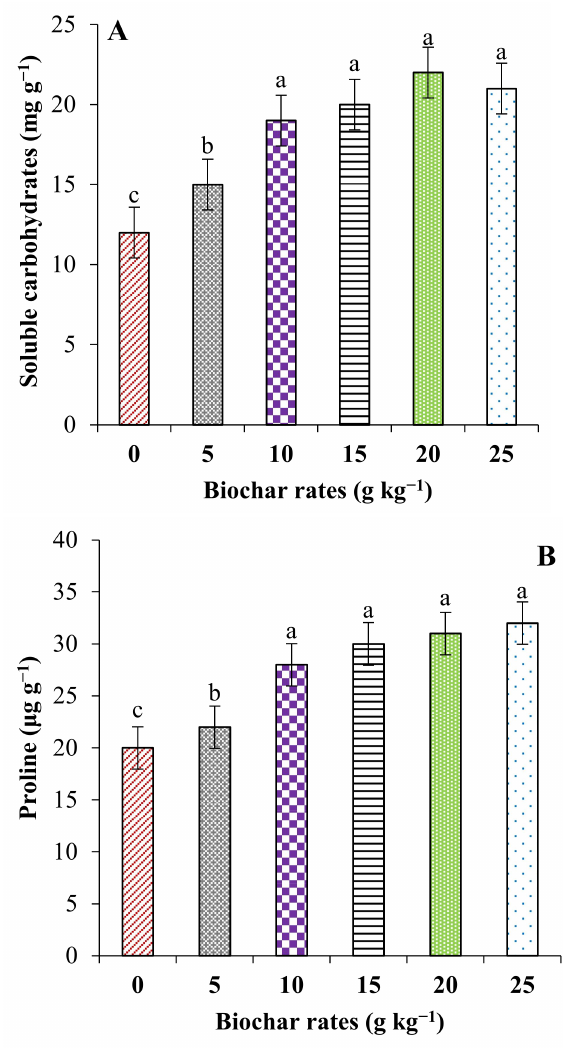
Figure 2. Effect of SWB on soluble carbohydrates and proline in the leaves of pearl millet plants. ( A ): soluble carbohydrates and ( B ): proline. Means ( ± SE) followed by different letters are significantly different according to Tukey’s test ( p ≤